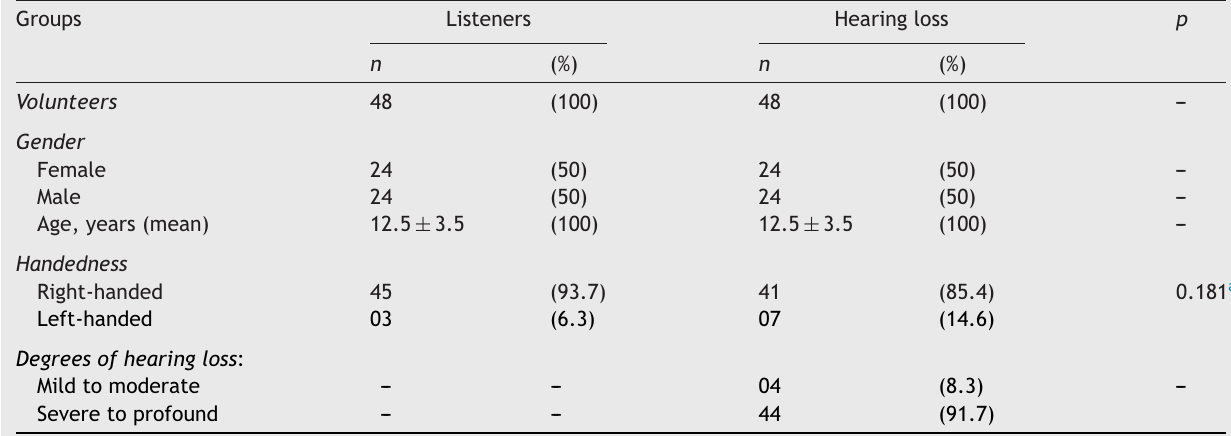
Table 2 Characterization of the studied